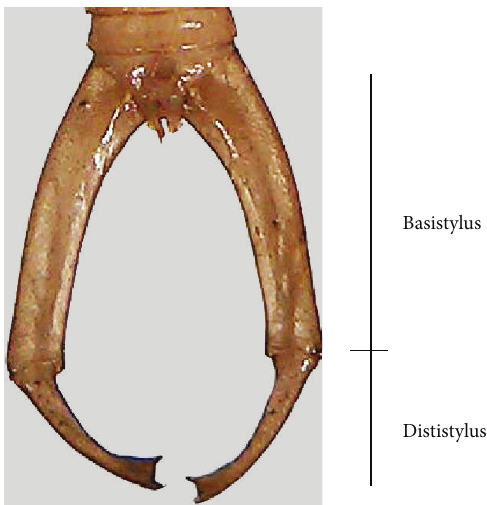
Figure 3: Clasper of male Merope tuber with basistylus and dististylus labeled.